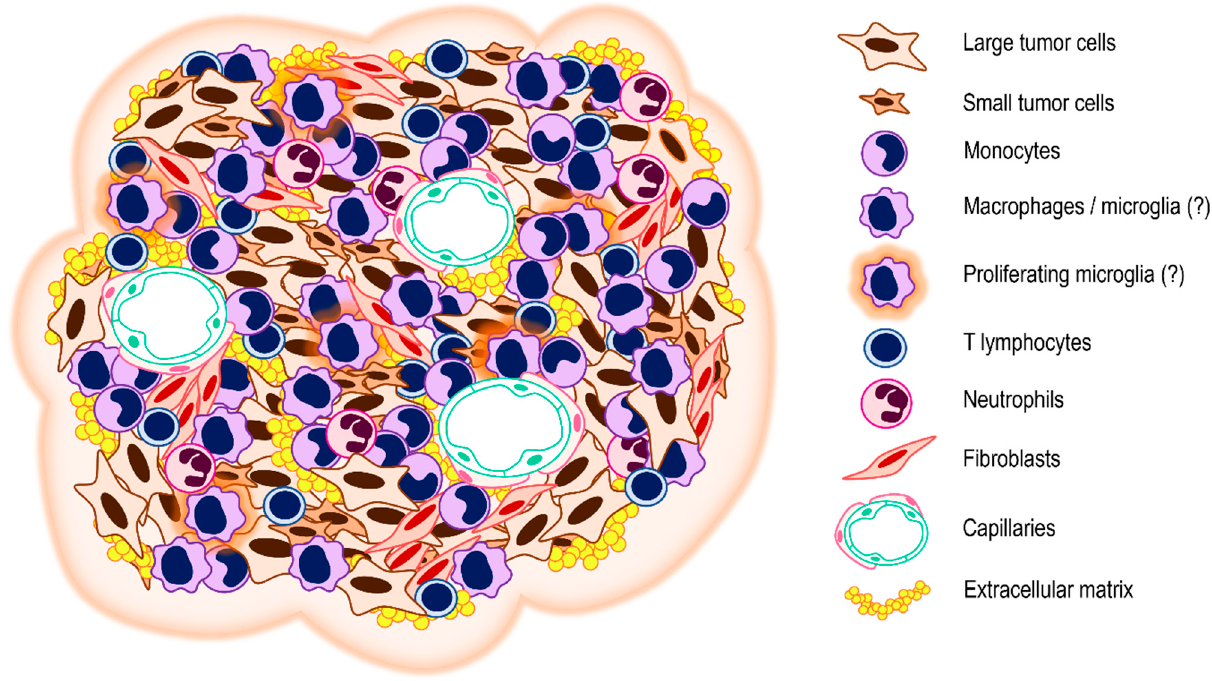
Figure 3. Schema of the VS tumor microenvironment. The tumor microenvironment is composed of the tumor cells themselves and the cellular and non ‐ cellular components of the tumor stroma. The cellular component of the tumor microenvironment of VS is a compound of immune cells and mesenchymal cells. The non ‐ cellular component involves structural proteins of the extracellular matrix, regulatory proteins, and communication molecules such as cytokines, chemokines, and growth factors.